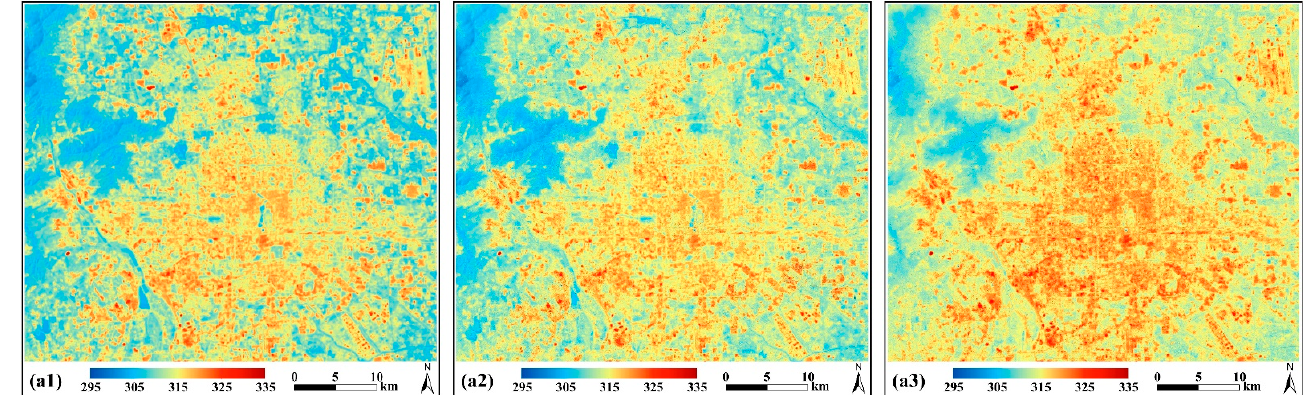
Figure 11. Spatial distribution of LST (K) data around the central urban area. ( a1 ) Retrieved 30 m LST (K) data, ( a2 ) MFGWML downscaled 10 m LST (K) data, and ( a3 ) the high-resolution urban thermal sharpener (HUTS) downscaled 10 m LST (K) data.